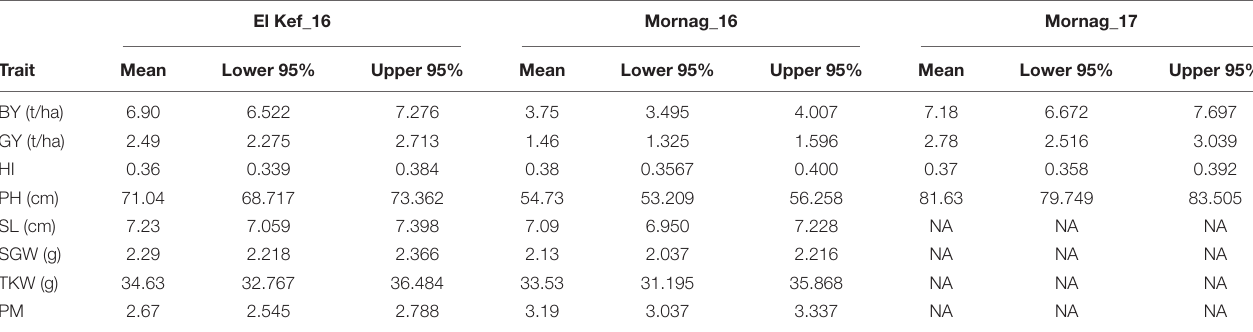
TABLE 4 | Agronomic traits means and confidence intervals of barley entries evaluated in different environments in